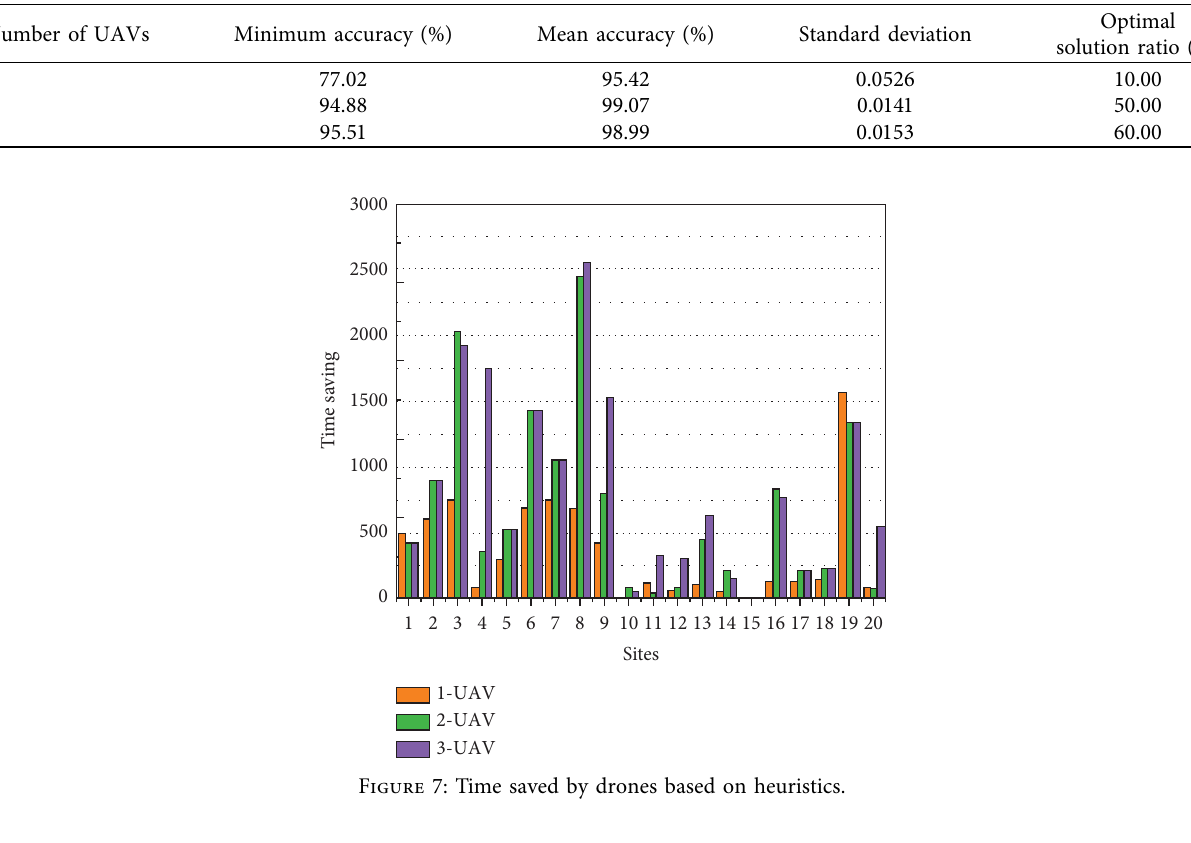
Table 3: Small scale solving statistics.